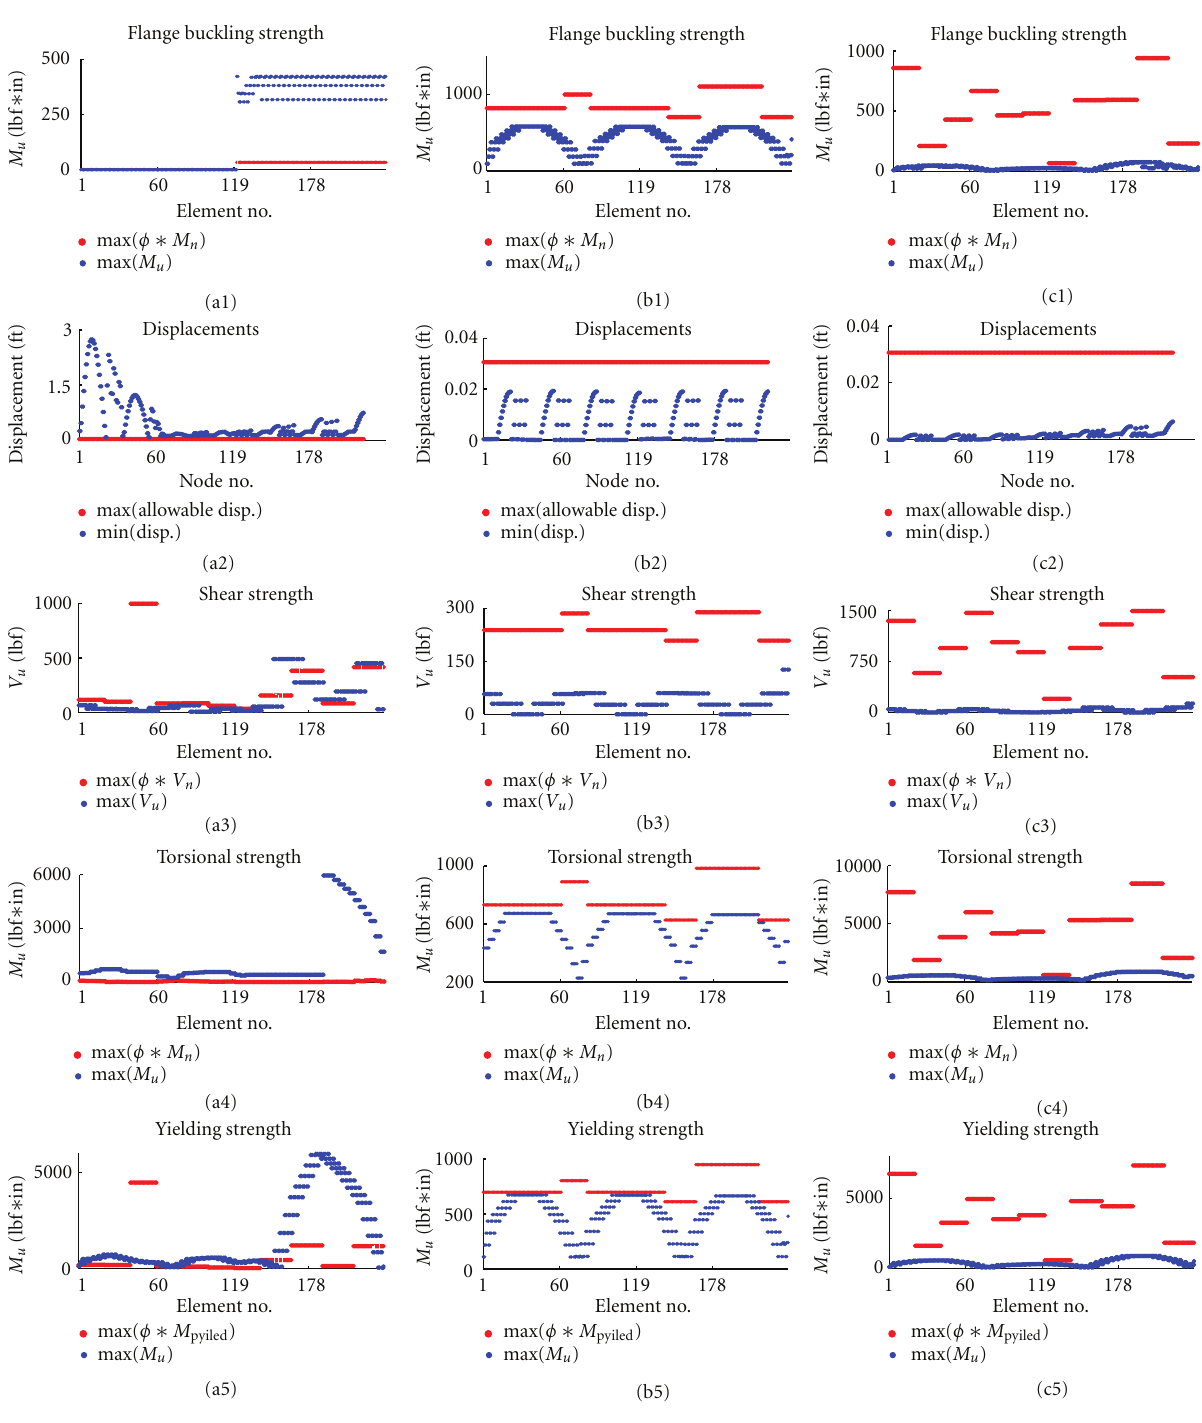
and a maximum weight (weight = 176334.6800 lb (79984.0654 kg) and displacement = 0.0066 ft (2.0116